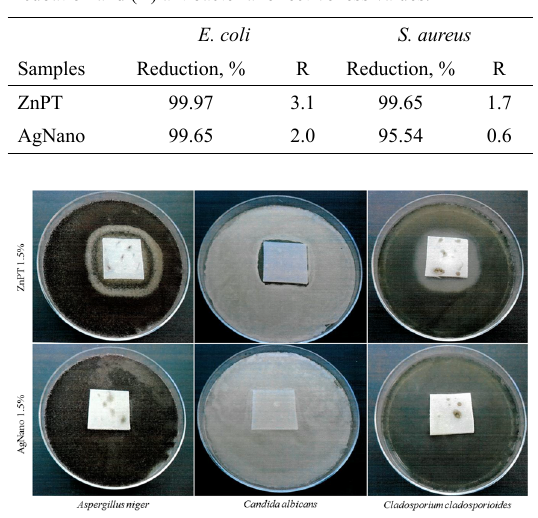
Figure 5. Antifungal activity of ZnPT and AgNano incorporated samples: (a) Aspergillus niger , (b) Candida albicans , (c) Cladosporium